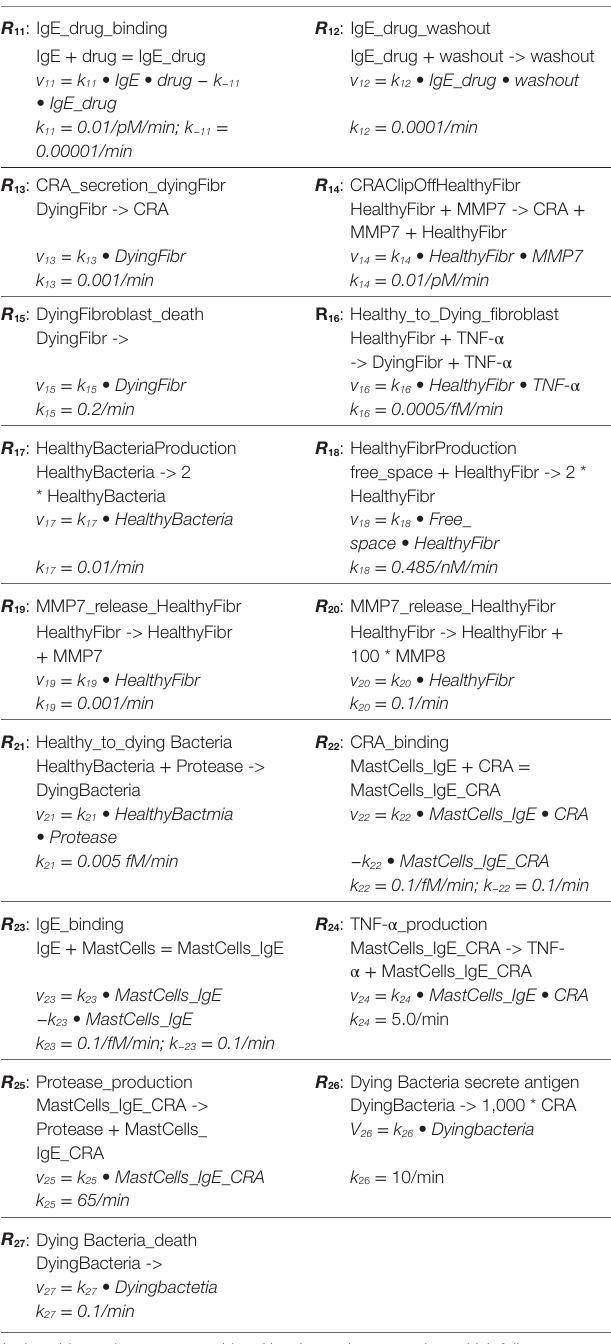
TaBle 1 | Reaction and rate equations for the processes considered in the mathematical